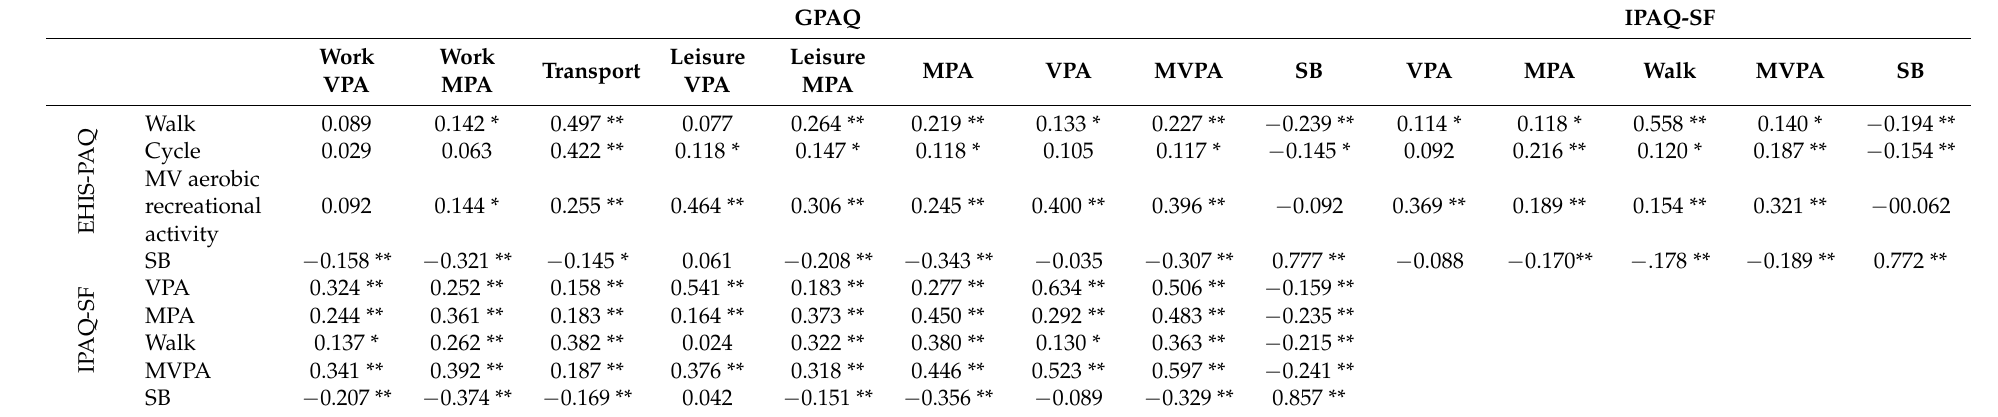
Table 3. Concurrent validity of IPAQ-SF, GPAQ, and